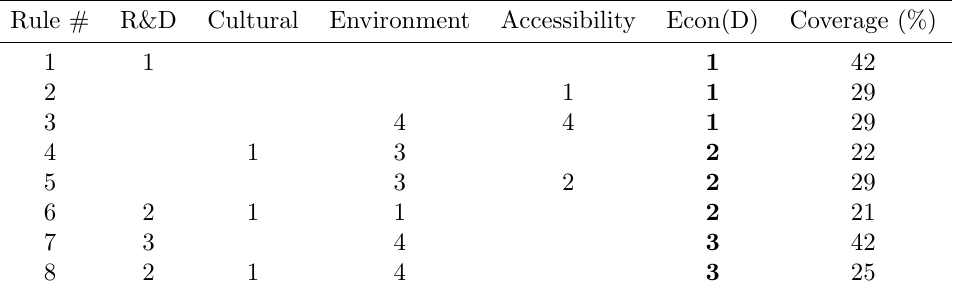
Figure 2. Three steps in the rough set approach using composite factors and sub-factors Figure 2: Three steps in the rough set approach using composite factors and sub-factors Legends: E = XXQ Economy L = XXQ Livability R&D = Research & Development Table 2: Rough set rules explaining XXQ Economy by composite factors using 4 classes Rule #